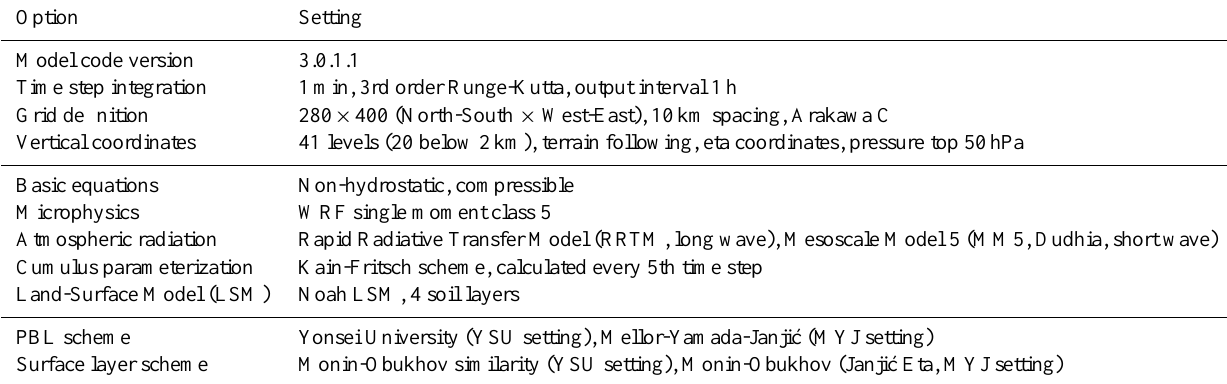
Table 1. Setup of WRF